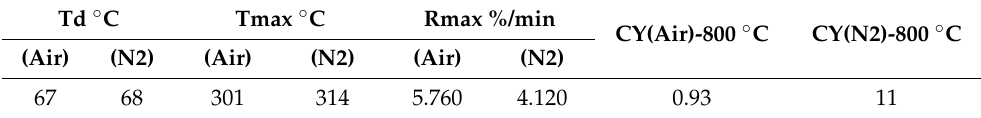
Figure 6. Thermogravimetric analysis of Catalpa bignonioides fiber (N 2 and air atmospheres). Table 2. TGA data in air and nitrogen